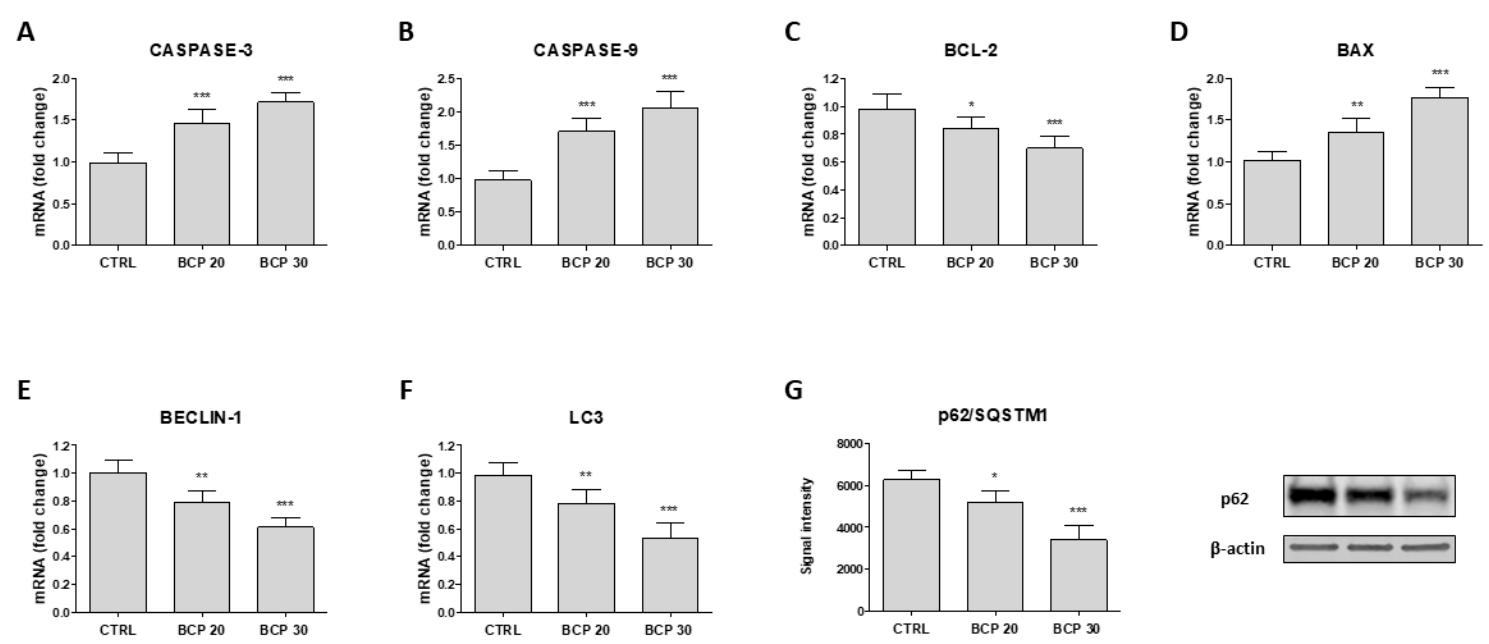
Figure 3. Effect of BCP on caspase-3 ( A ), caspase-9 ( B ), BCL-2 ( C ), BAX ( D ), BECLIN-1 ( E ), and LC3 ( F ) mRNA expression in U373 cells. ( G ) The graph represents p62/SQSTM1 protein expression. mRNA levels are calculated according to the 2 −ΔΔ Ct method as fold change relative to normal controls. Treatment with BCP significantly reduced p62 protein expression compared to the control; the blots were quantified by densitometric analysis. The data are expressed as signal intensity and as means ± SD; * p < 0.05, ** p < 0.01, *** p < 0.001 vs. the control.